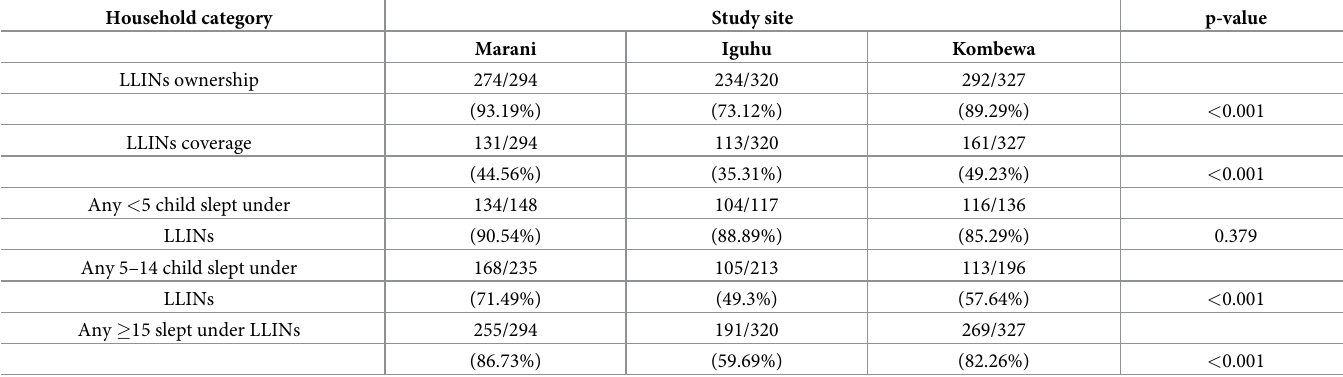
Table 7. Household long lasting insecticide treated mosquito nets (LLINs) use and ownership survey in December 2016 in Western